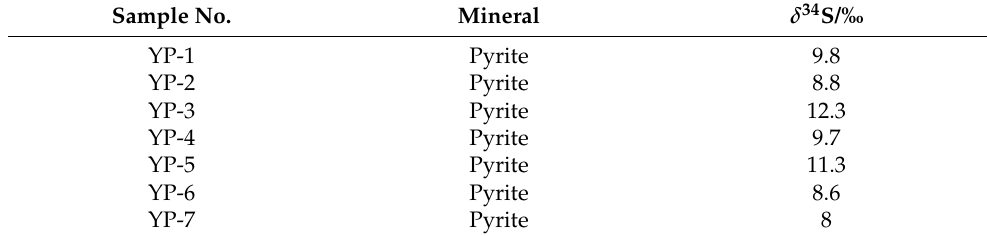
Table 2. Sulfur isotopic data of ore-bearing pyrite from the Lijiapuzi gold deposit. Sample No.